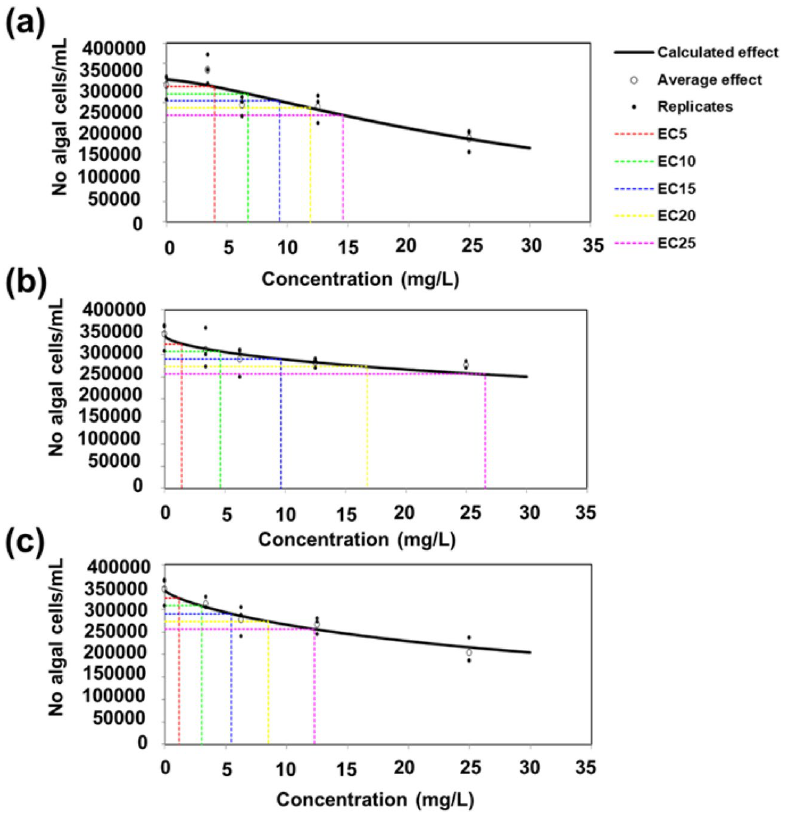
Figure 10. Inhibitory effect of nettle CNS at different concentrations on algal cell number after 72 h. CNS from stem 1: 1 ( a ), CNS from leaves 1:1 ( b ), CNS from leaves 1:2 ( c ).